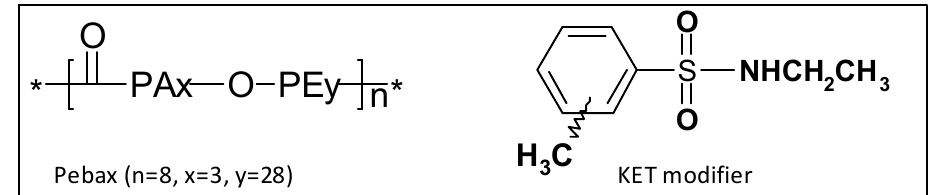
Scheme 1. Molecular Structures of PEBAX chain repeat unit and N -ethyl-o/p-toluene sulfonamide (KET)